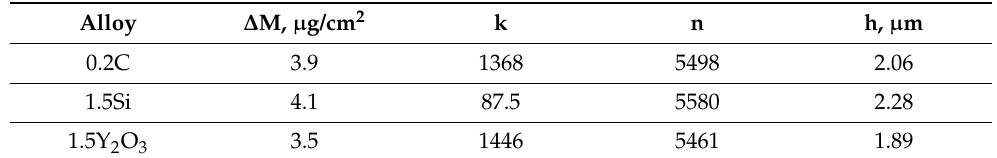
Figure 4. The oxidation kinetic curves after isothermal annealing at 800 ◦ C. Table 2. The oxidation kinetics characteristics of the 0.2C, 1.5Si, and 1.5Y 2 O alloys at 800 ◦ C and the values of the oxide layer thickness (h) after 30 h of isothermal holding.